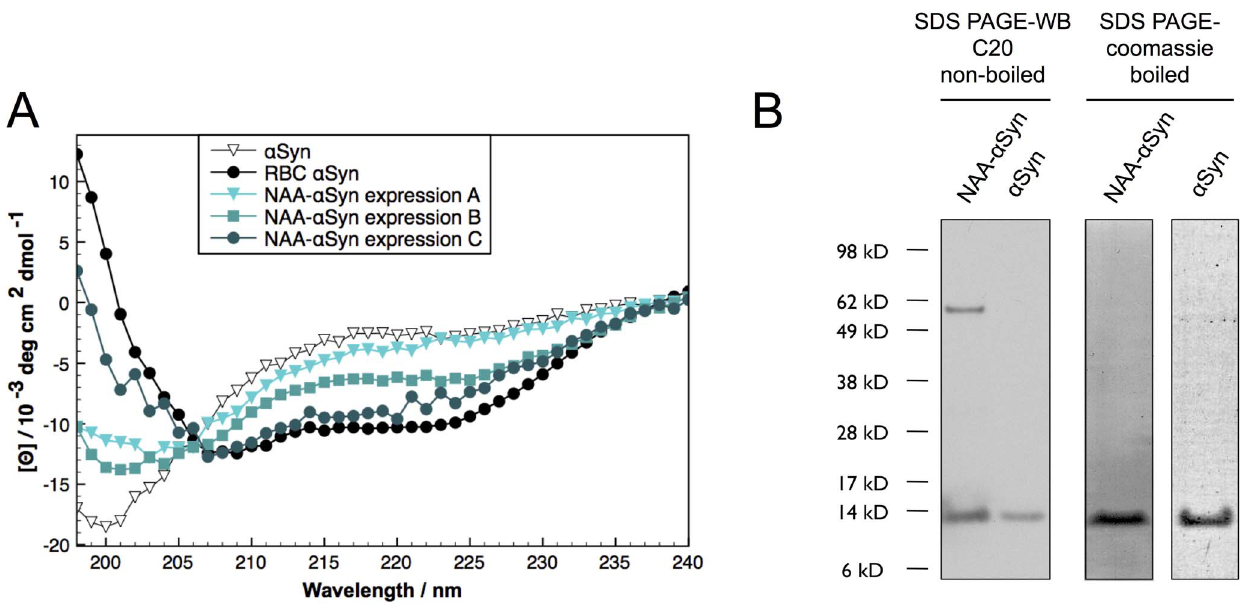
Figure 1. Variability in the folding of purified recombinant NAA- a S under non-denaturing conditions. A: CD spectroscopy of bacterially expressed and purified NAA- a S and a S under non-denaturing conditions. No variability in the secondary structure was seen with unmodified a S. In contrast, NAA- a S showed batch-to-batch variability in folding of the obtained preps. B: SDS-PAGE Western blot and Coomassie stain of a S and NAA- a S (‘‘expression C’’). The samples were not boiled in SDS-sample buffer before gel loading for Western blotting. The NAA- a S banding pattern indicates some SDS-stable tetrameric protein present in the sample, while no higher bands could be detected in non-acetylated a S. For coomassie staining, the samples were boiled in sample buffer, leading to a single stainable band at 14 kDa, indicative of the high purity of the sample.